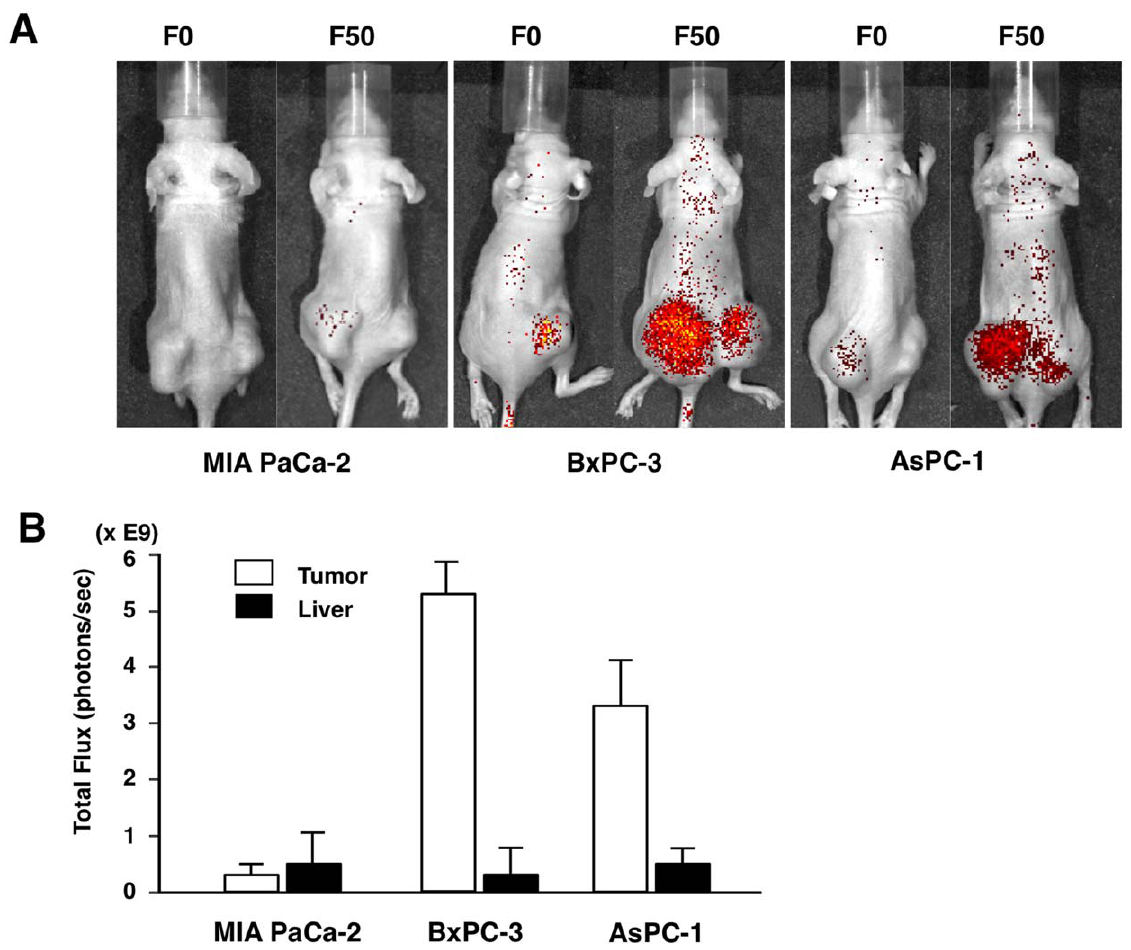
Figure 5. Pretreatment with D-mannose does not affect accumulation of F50-Liposome-Cy5.5. ( A ) Fuc-Liposome- or Liposome-Cy5.5 was administered via the tail vein (50 m l/mouse). The tumor regions of MIA PaCa-2, BxPC-3 and AsPC-1 cells (the back side of a bilateral flank lesion) in the mouse was observed and Cy5.5 accumulation was quantified using the IVIS imaging system at 96 hours after injection. D-mannose (1000-fold of the L-fucose) was injected simultaneously with liposome injection. ( B ) Total flux of the tumor and liver was calculated by using Living Image software according to the manufacturer’s instructions.